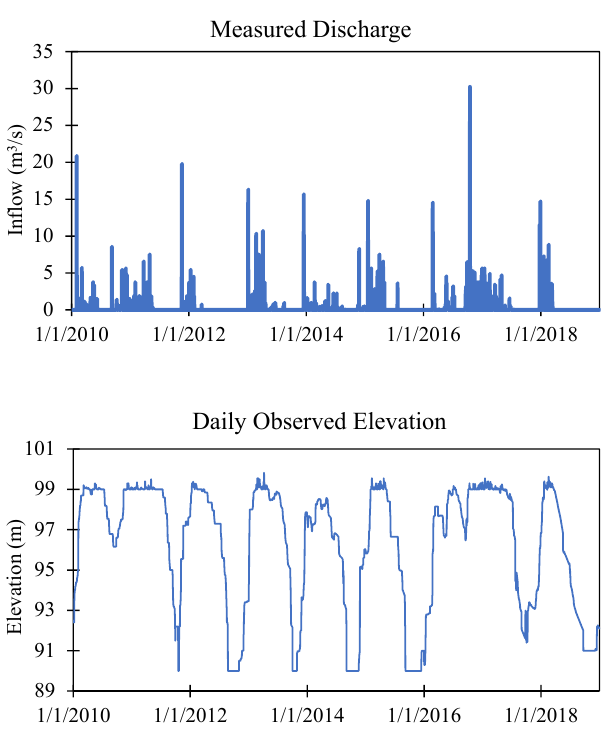
Figure 4. Maximum daily rainfall data for Ketro ground station, TRMM, and CHIRPS databases.